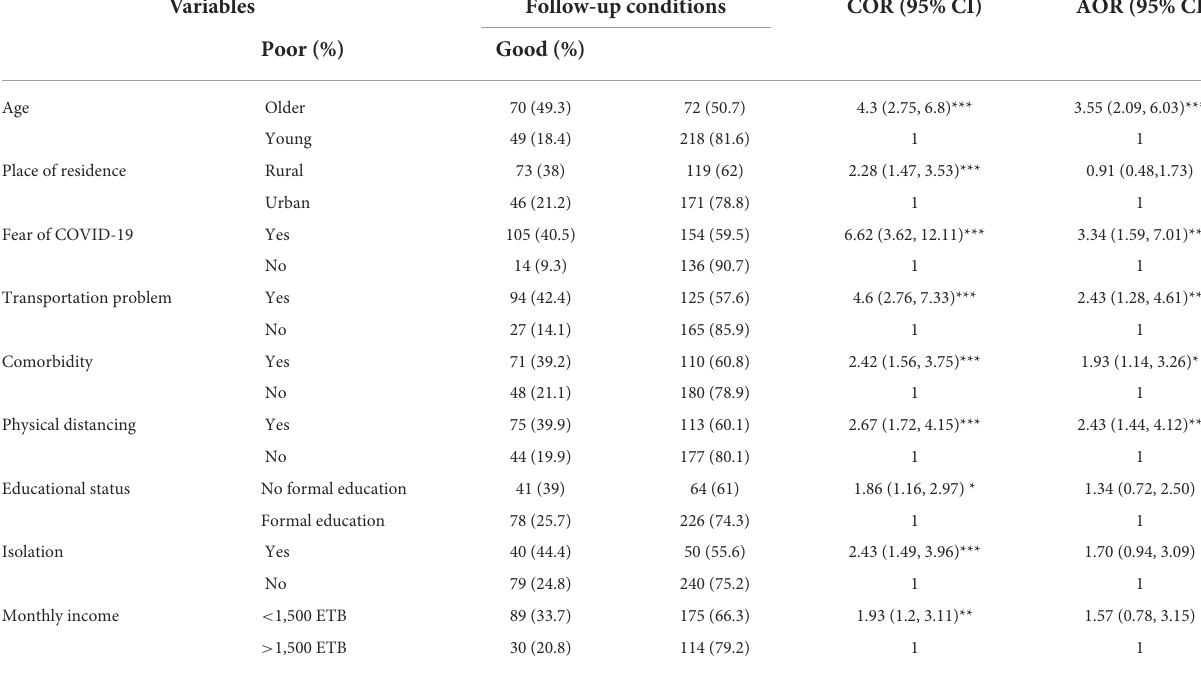
TABLE 4 Bivariable and multivariable logistic regression analysis depicting factors associated with poor follow-up conditions of care among adult hypertensive patients at West Arsi public health facilities, Ethiopia, 2021 ( N = 409). Variables Follow-up conditions COR (95% CI) AOR (95% CI Poor (%) Good (%)